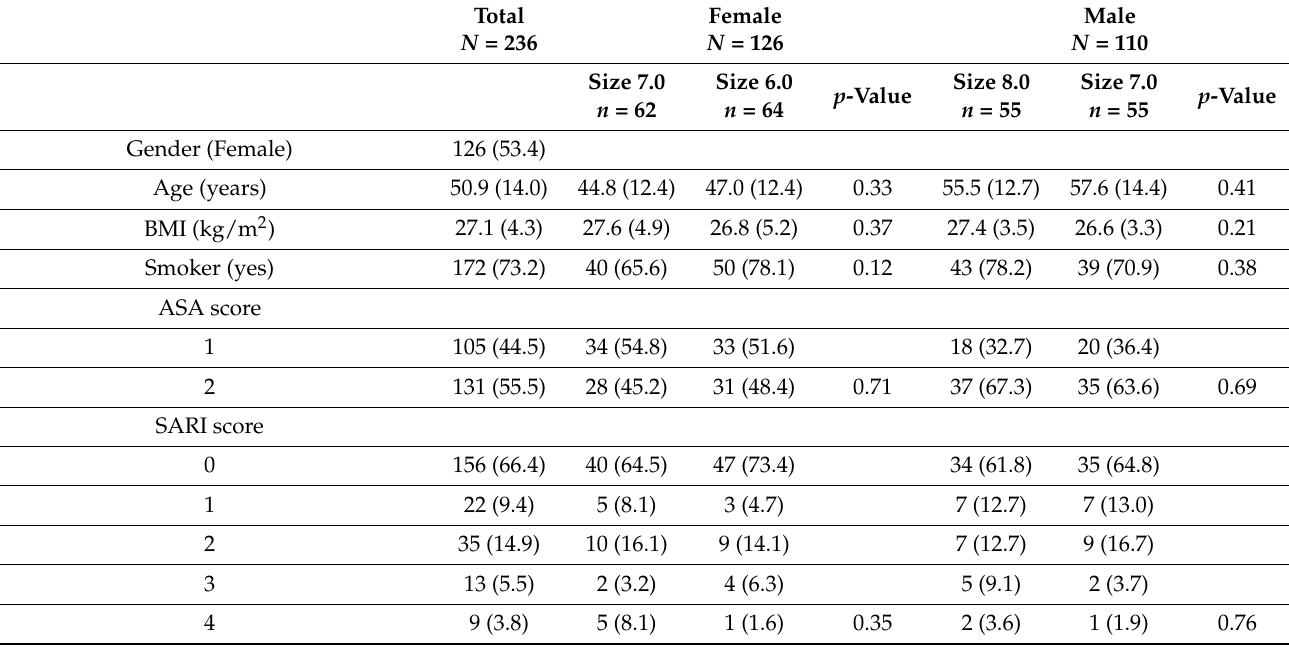
Table 2. Patient and surgery